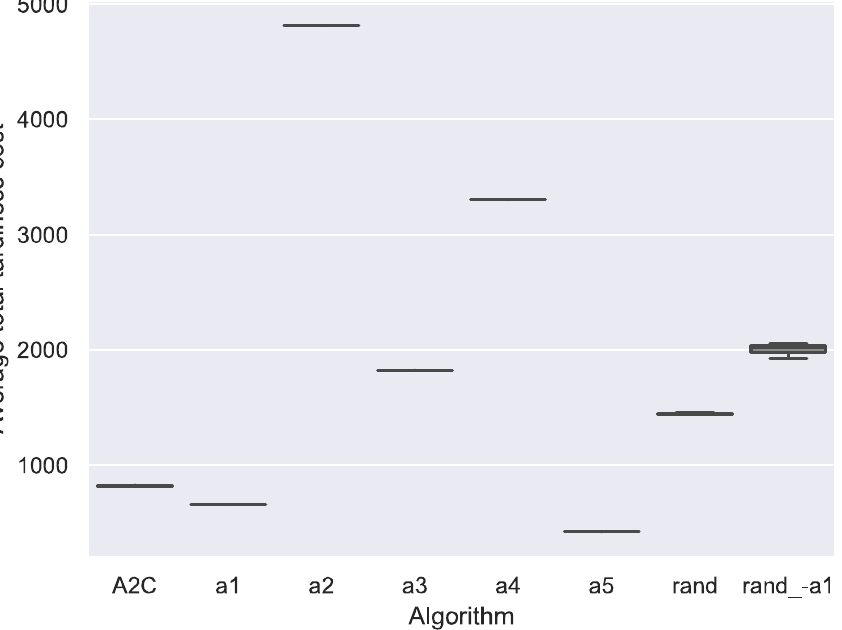
Figure 8. Comparison between A2C and SDR considering average total tardiness cost on extended instances.